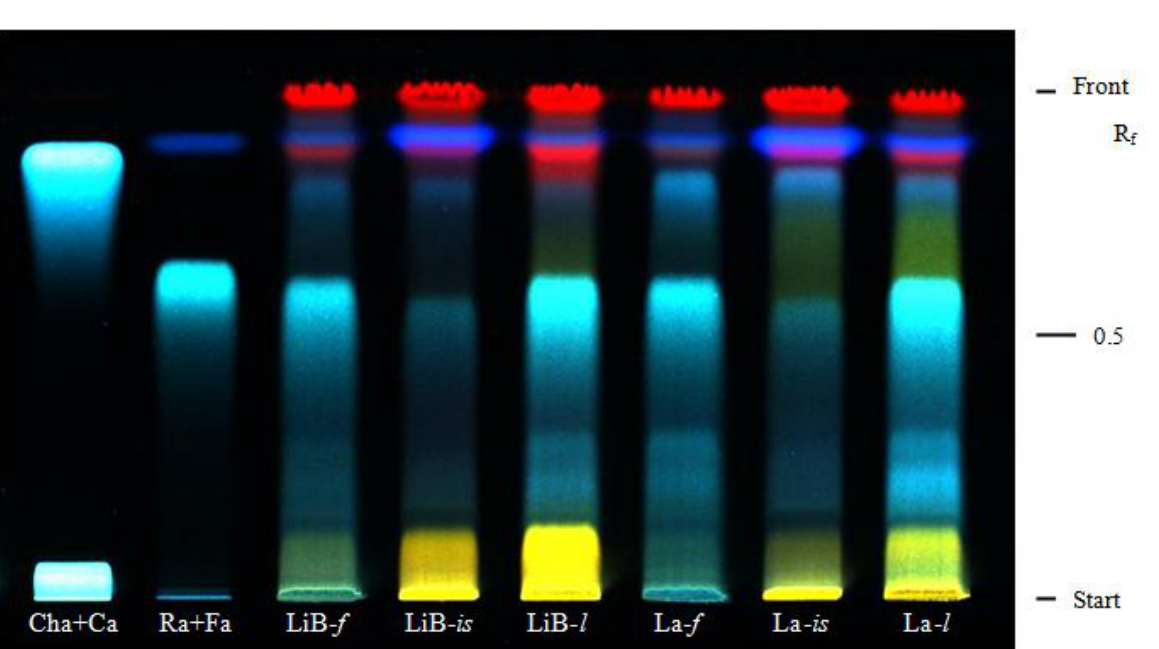
Figure 1. HPTLC chromatogram of phenolic acids in Lavandula x intermedia 'Budrovka' and L. angustifolia